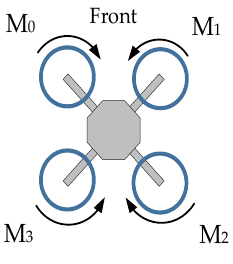
Figure 8. Motor markings.